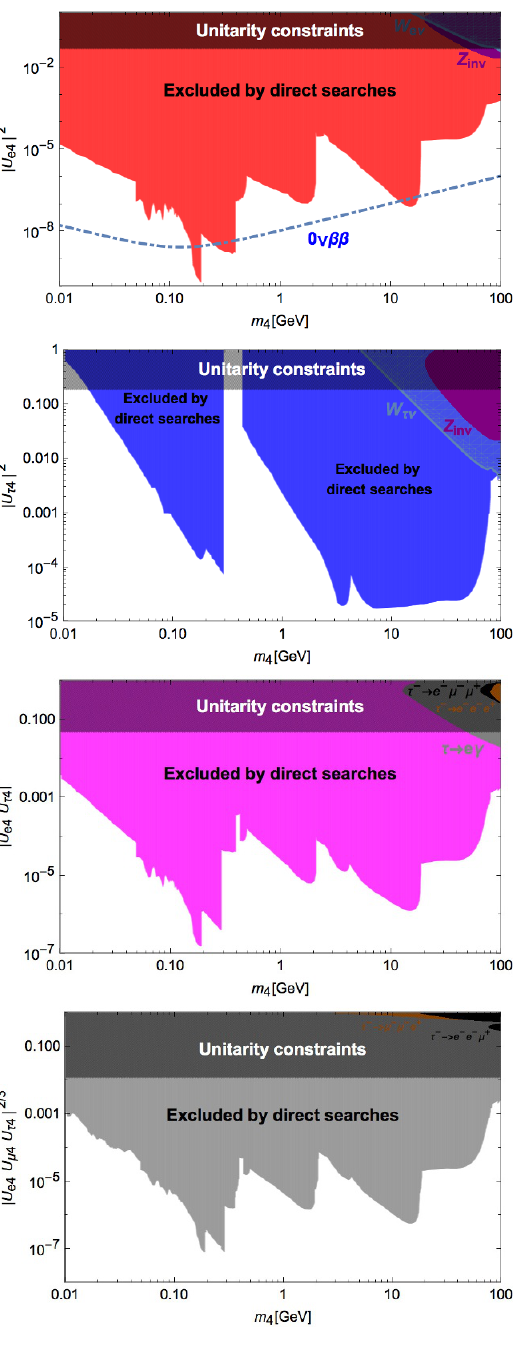
Figure 3 . Updated constraints on the sterile neutrino parameter space, as spanned by various combinations of U ‘ mixing elements and m 4 (in GeV): from left to right, top to bottom, j U e 4 j 2 , (cid:11) 4 j U (cid:22) 4 j 2 , j U (cid:28) 4 j 2 , j U e 4 U (cid:22) 4 j , j U e 4 U (cid:28) 4 j , j U (cid:22) 4 U (cid:28) 4 j and j U e 4 U (cid:22) 4 U (cid:28) 4 j 2 = 3 . Solid surfaces denote excluded regimes due to violation of at least one experimental or observational bound.